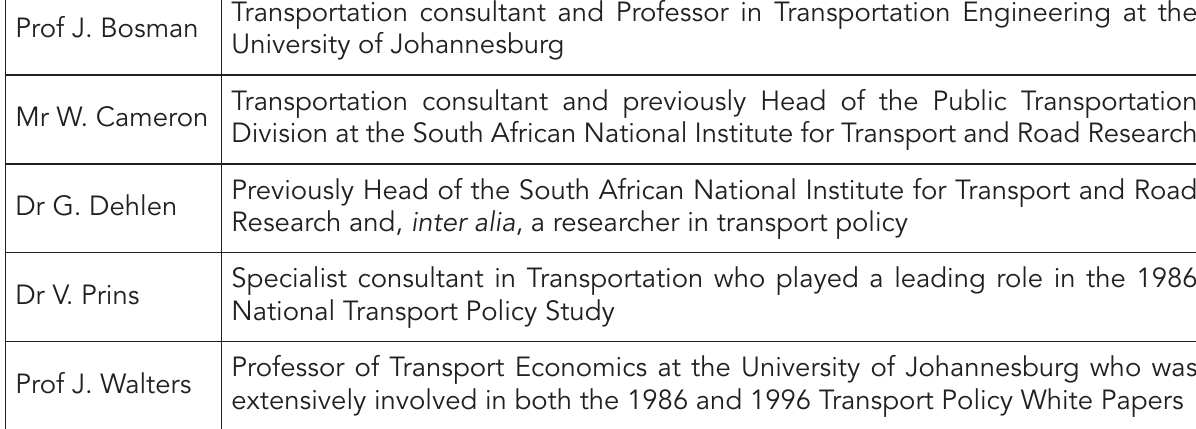
Table A1: Persons consulted in the qualitative narrative research analysis of the exogenous factors influencing transport policy formulation in South Africa